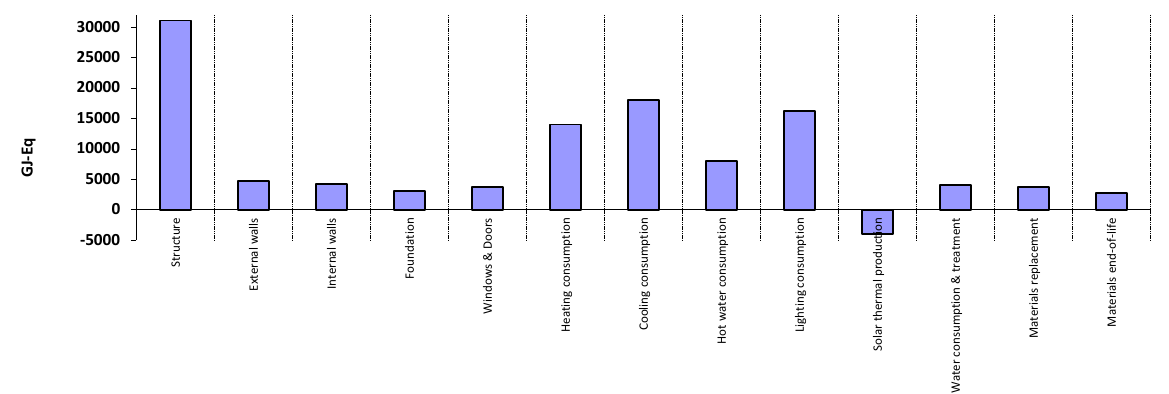
Figure 1. Cumulative primary energy demand disaggregated into the different aspects of the building’s life cycle.